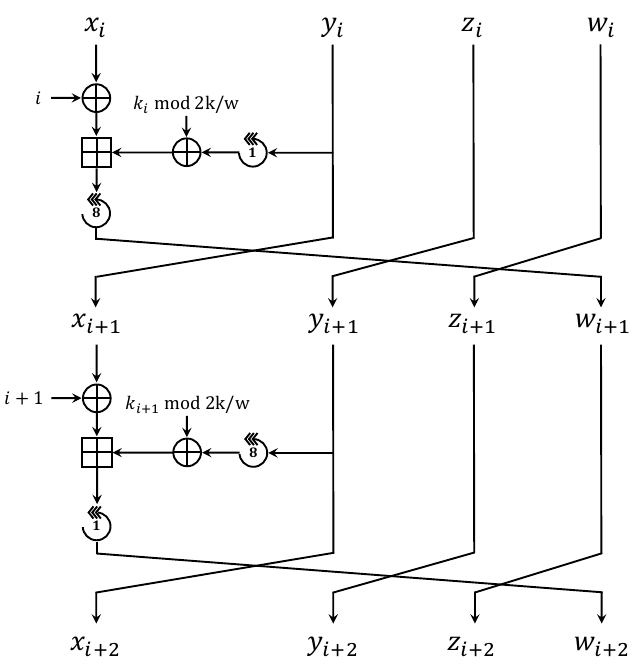
Figure 1. Two consecutive rounds beginning with the even i th round in CHAM.